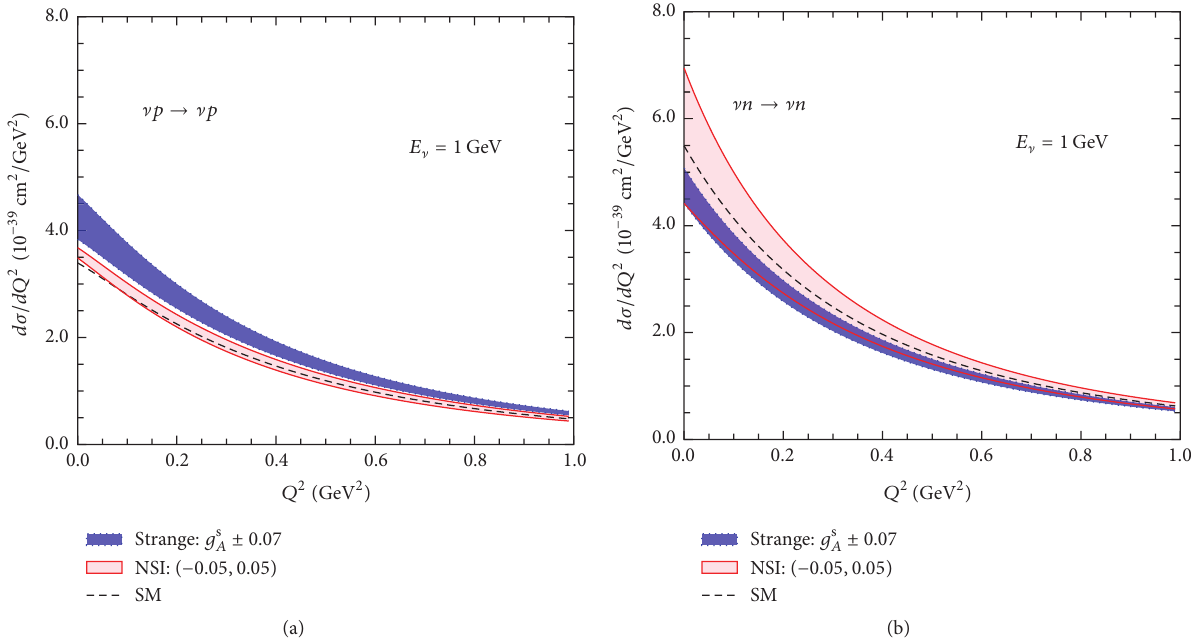
Figure 3: Differential cross section with respect to the momentum transfer for SM, strange quark, and NSI, for ] 𝑝 → ] 𝑝 (a) and ] 𝑛 → ] 𝑛 scattering (b). For details, see the text.